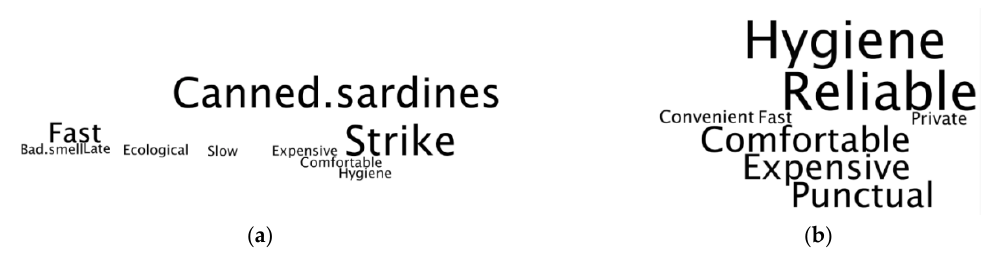
Figure 2. ( a ) Word cloud of over ground train transport inside Lisbon municipality; ( b ) Word cloud of over ground train transport outside Lisbon municipality.